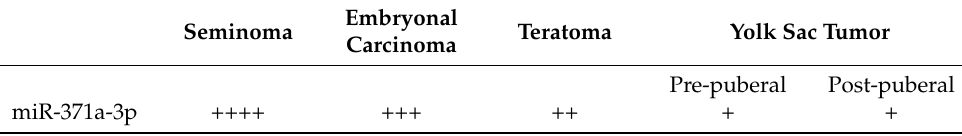
Table 1. miR-371a-3p levels as discriminative diagnostic